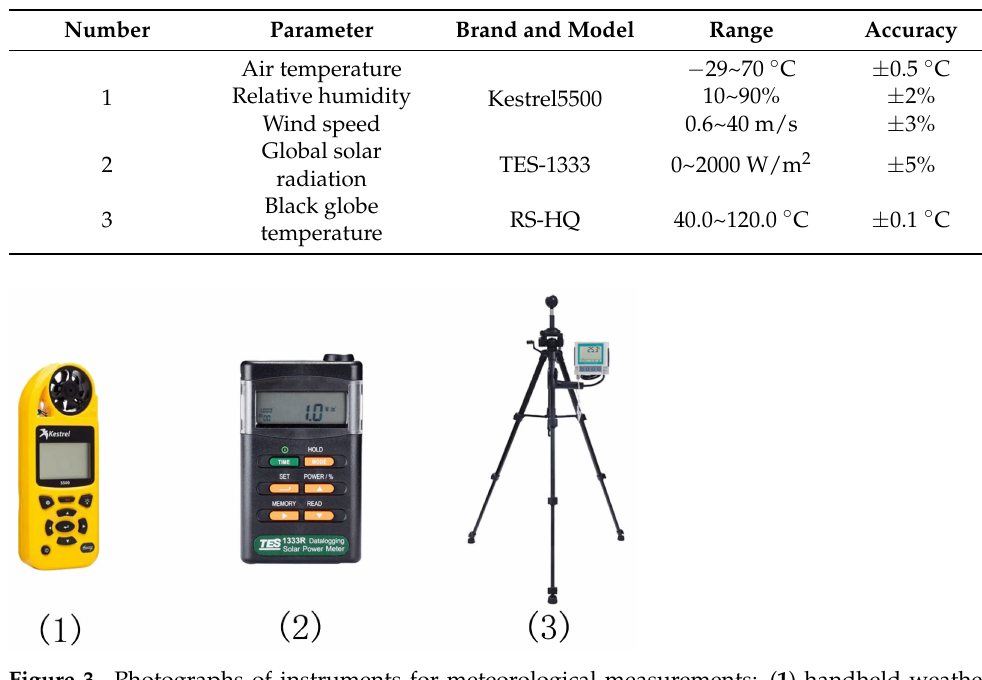
Figure 3. Photographs of instruments for meteorological measurements: ( 1 ) handheld weather recorder, ( 2 ) global solar radiometer, and ( 3 ) black globe